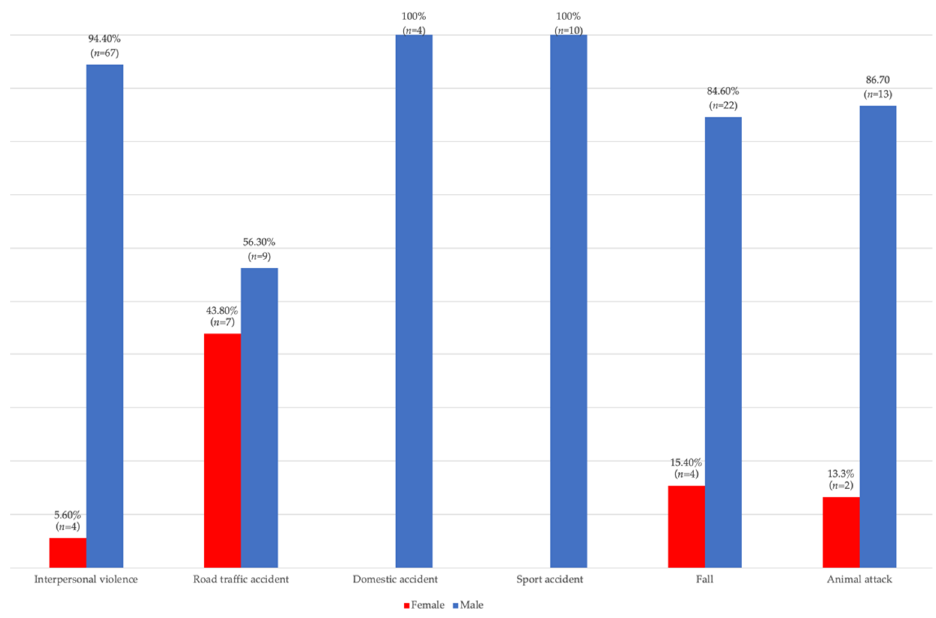
Figure 3. Distribution according to gender and etiology.